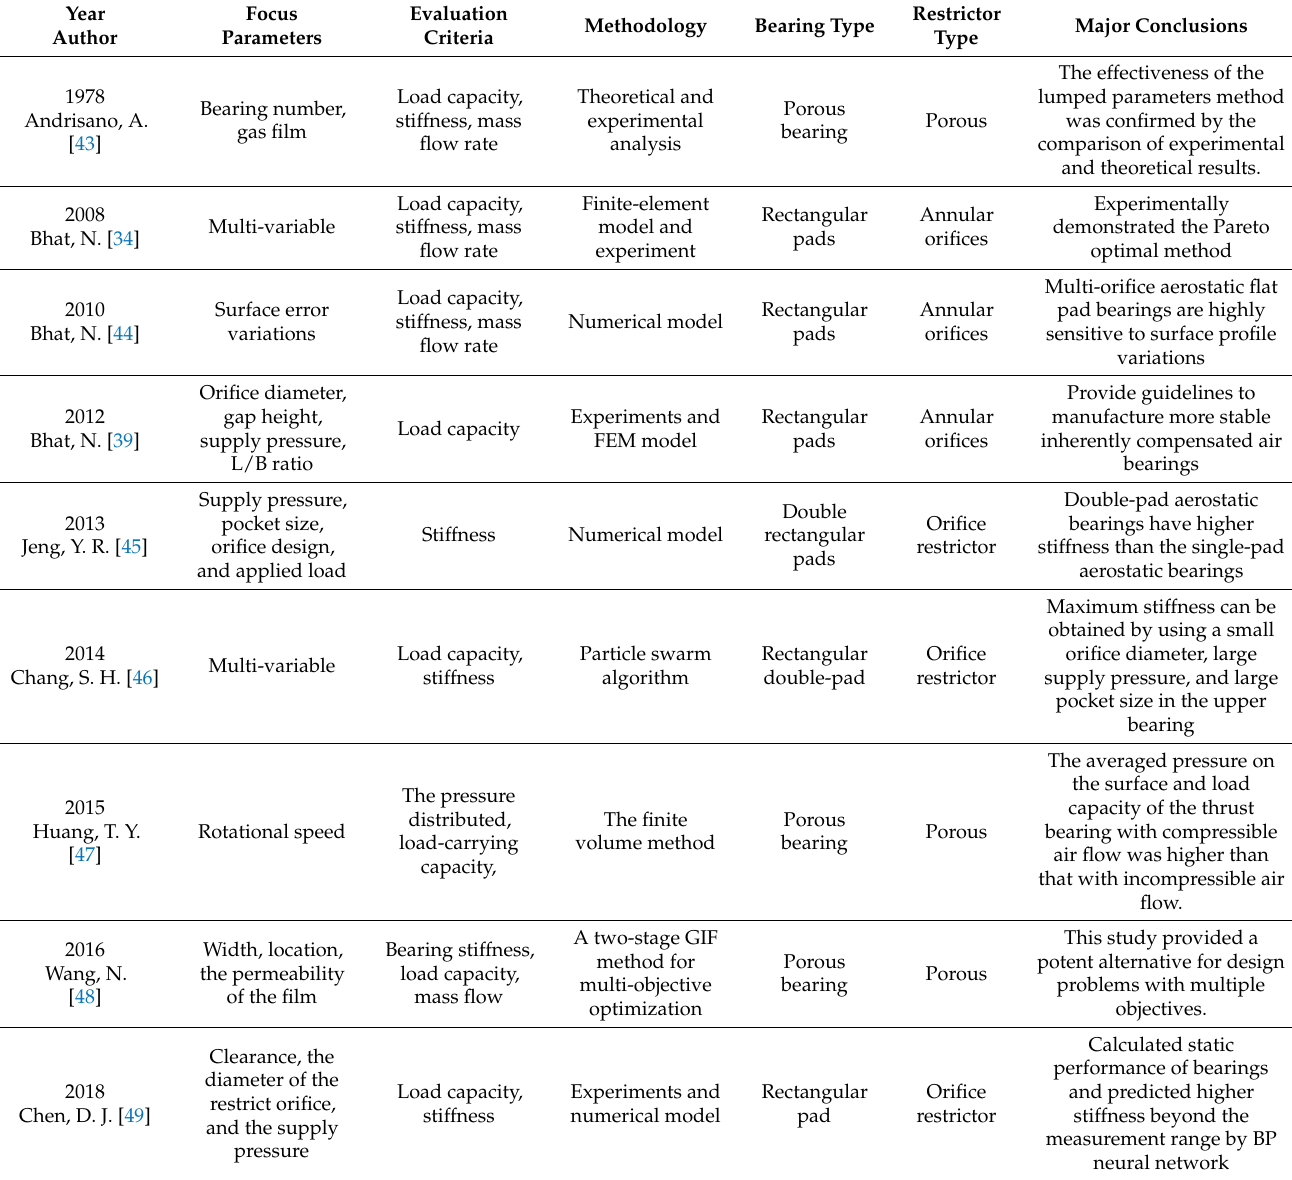
Table 1. Static performance of